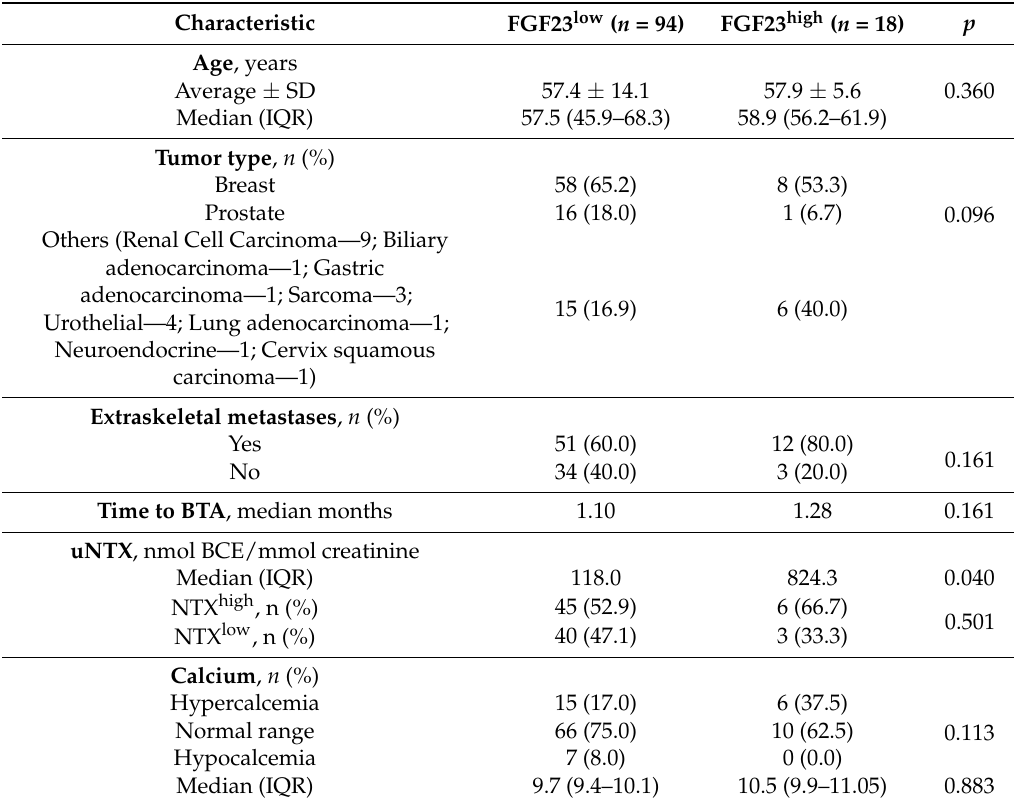
Table 1. Baseline characteristics of the cohort